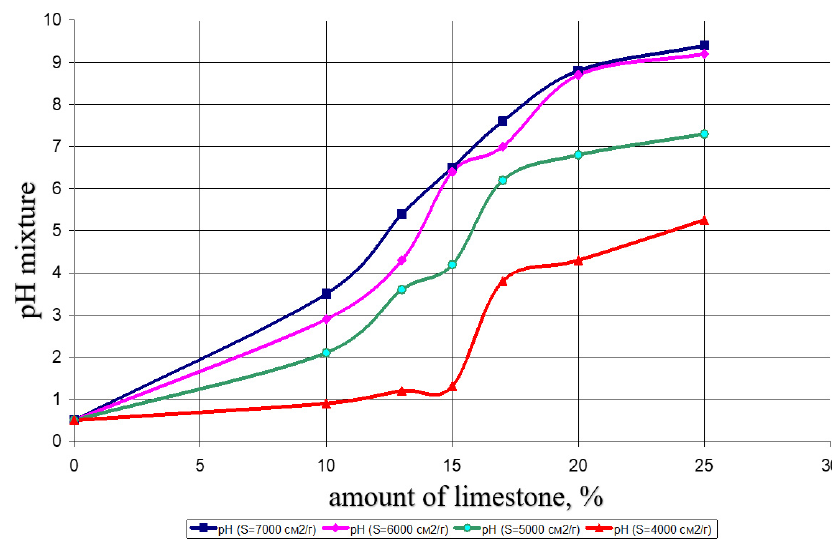
Figure 2. The dependence of the pH of the mixture on the amount of limestone.